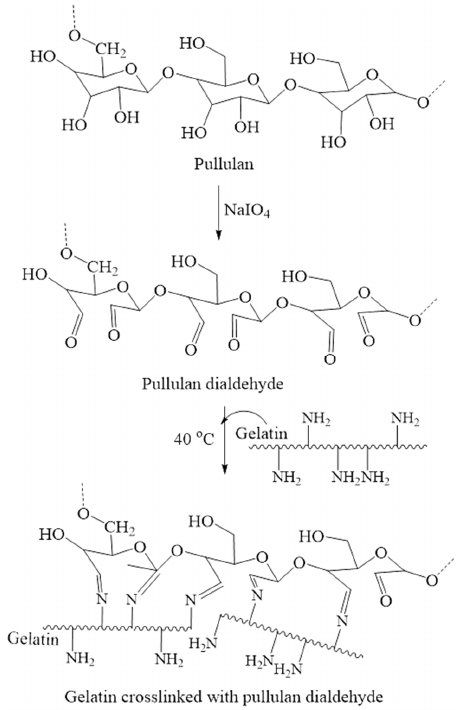
Figure 8. Reaction showing the formation of pullulan dialdehyde on oxidation of pullulan with sodium periodate, followed by crosslinking with gelatin at 40 °C. 2.2.4. N ‐ hydroxysulfosuccinimide and Aryl Sulfonyl Fluoride